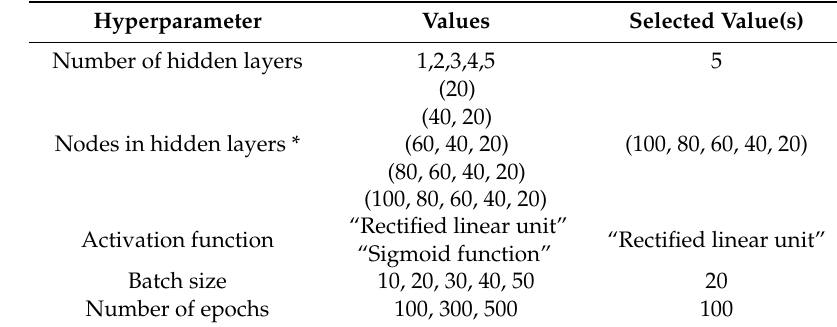
Table 2. Various hyperparameters and several potential values for corresponding hyperparameters tested for the best performance of the custom deep neural network system using the grid search cross validation method. A total of 150 trials were conducted to obtain the best set of